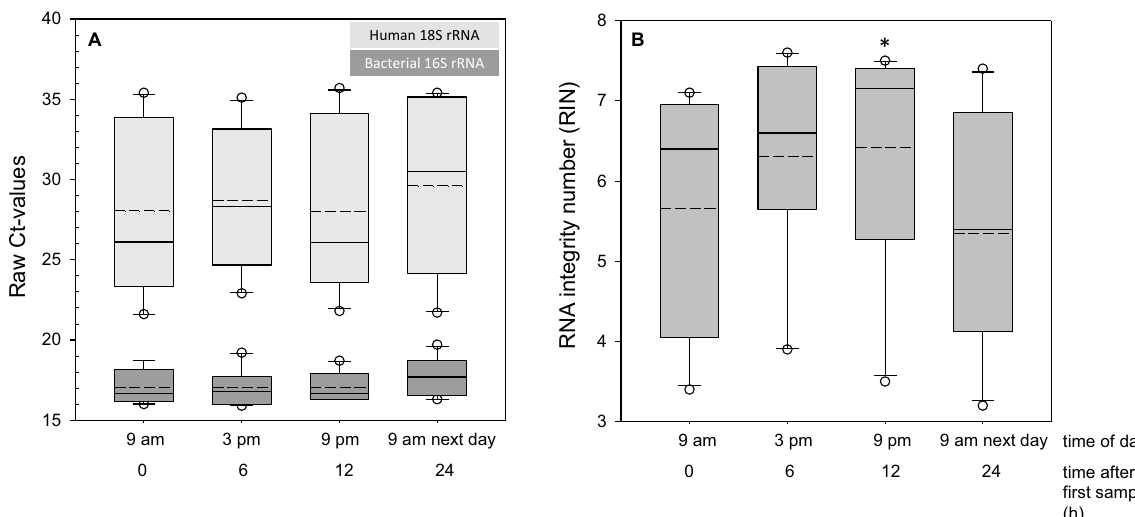
Figure 4. Box plots in ( A ) show the human 18S rRNA and bacterial 16S rRNA raw Ct-values for whole saliva samples (total n = 40) per time point (each n = 10: 9 am—0 h; 3 pm—6 h; 9 pm—12 h; 9 am next day—24 h). The input amount for cDNA synthesis for each sample was 0.5 µg. The box plots in ( B ) represent the quality of isolated RNA using RNA integrity numbers (RIN) for saliva samples (total n = 40) per time point (each n = 10). Dashed lines represent the mean, solid lines the median and dots the outliers. The asterisk (*) refers to a P value < 0.05 using 9 am measurements as the